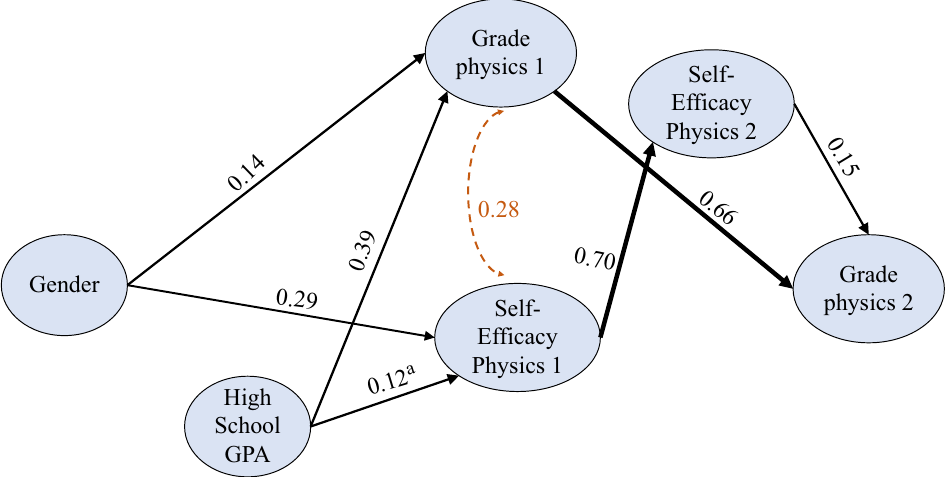
FIG. 3. Result of the path analysis part of the SEM without SAT math between gender and physics 2 grade through students ’ self- efficacy for model 2. The line thickness indicates the relative magnitude of β values. The dashed lines indicate covariances between constructs. p values are indicated by no superscript for p < 0 . 001 and superscript “ a ” for p ¼ 0 . 008 . Gender does not directly predict the physics 2 grade.